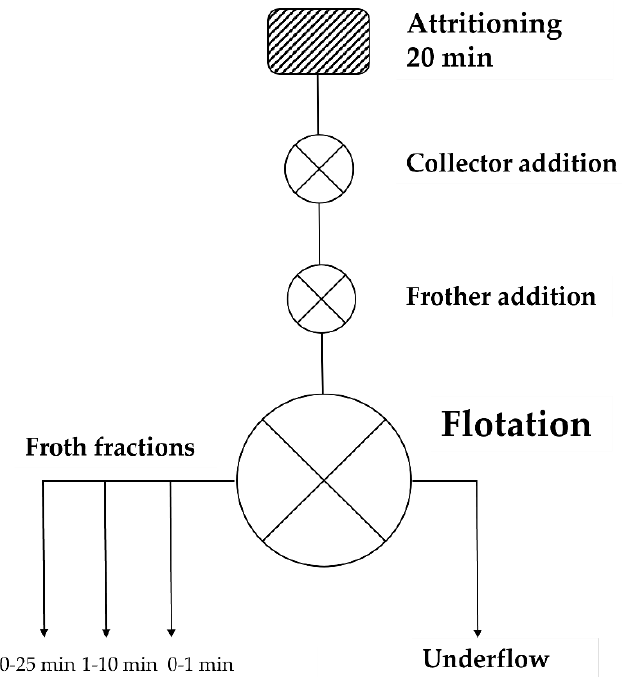
Figure 2. Experimental setup of the flotation Figure 2. E xperimental setup of the flotation experiments.